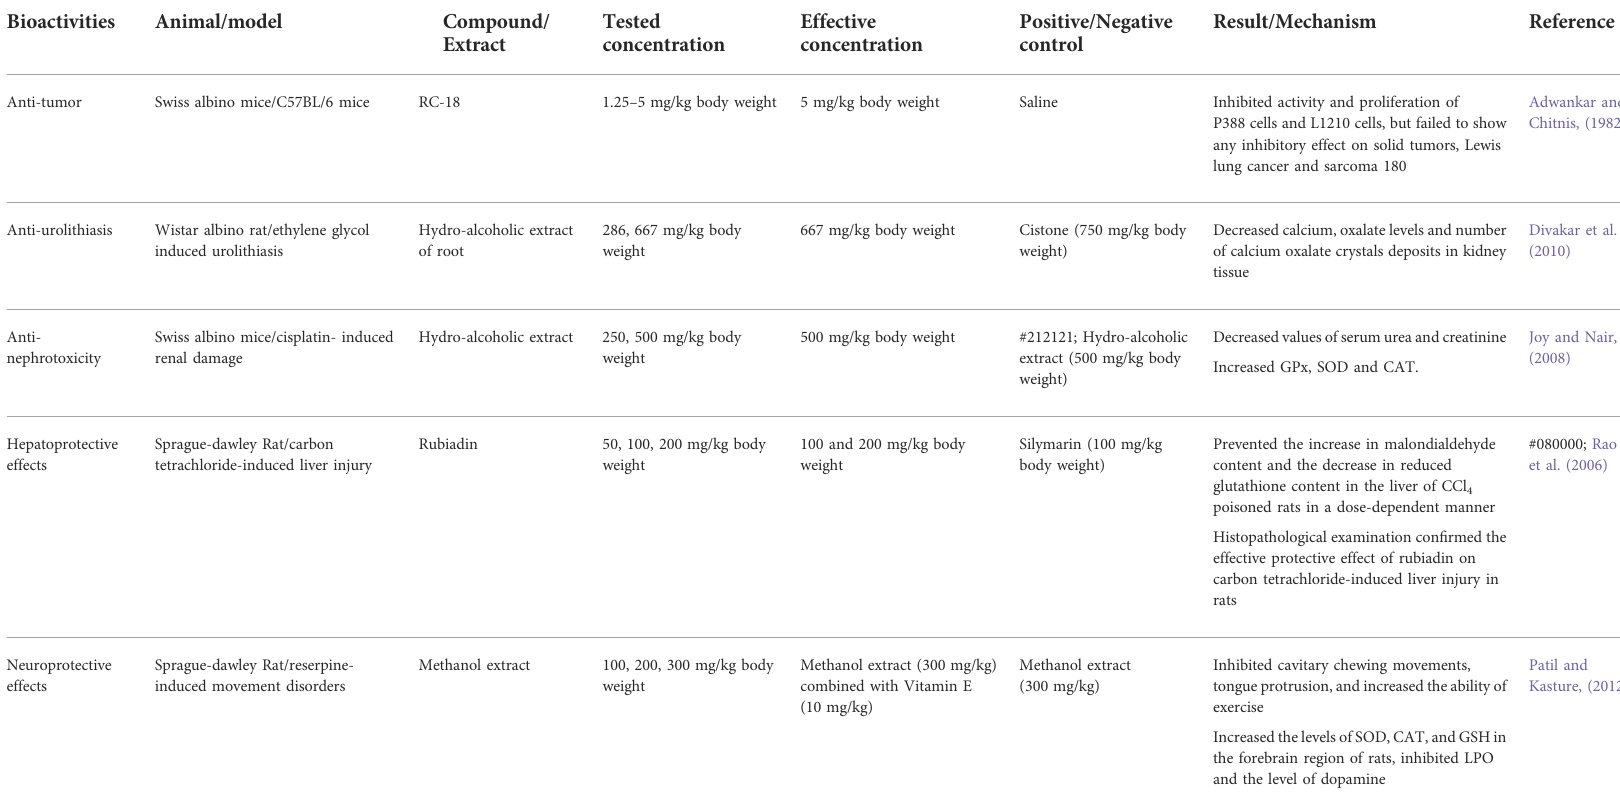
TABLE 3 ( Continued ) In vivo study on the pharmacological effects of R. cordifolia